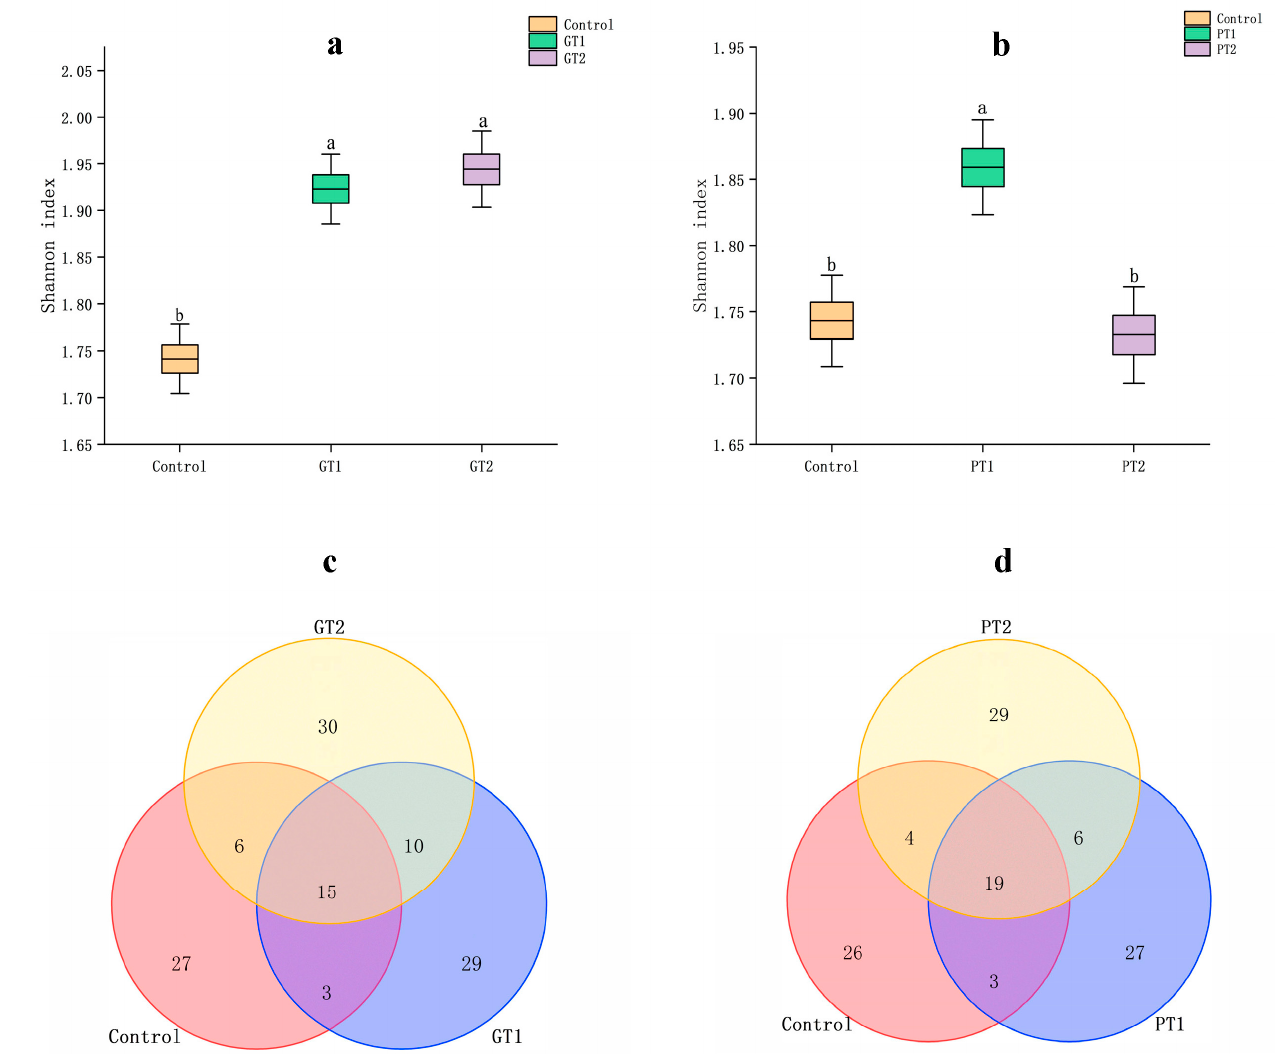
Figure 4. Bacterial community of Shannon diversity indices for the control, GT1 and GT2 treatment groups ( a ), and the control, PT1 and PT2 treatment groups ( b ). Venn diagrams of BSFL gut for the control, and GT1 and GT2 treatment groups ( c ) PT1 and PT2 treatment groups ( d ). Error bars represent standard deviation of triplicates. Columns marked by the same small letter do not significantly vary ( p > 0.05).